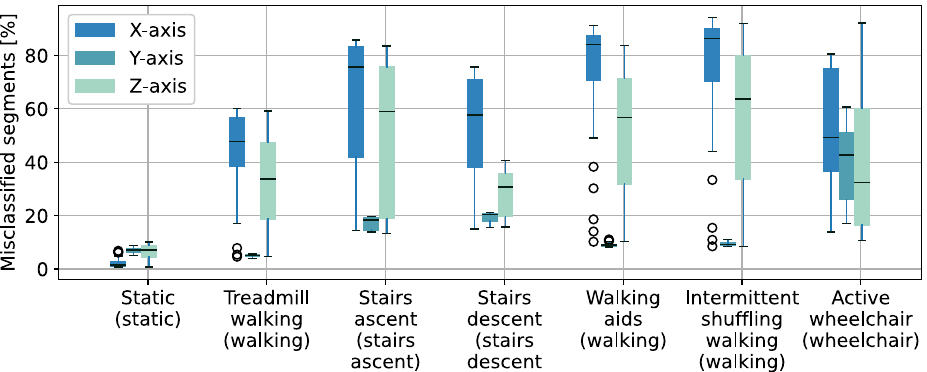
Figure 4. Percentage of misclassified segments when testing the baseline model with rotations from 0 to 180 degrees applied to each axis separately. Misclassified segments correspond to the amount of false negative predictions for the specific